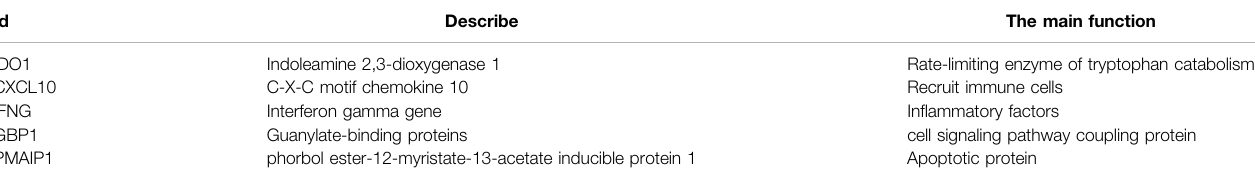
TABLE 3 | Introduction to the fi ve target